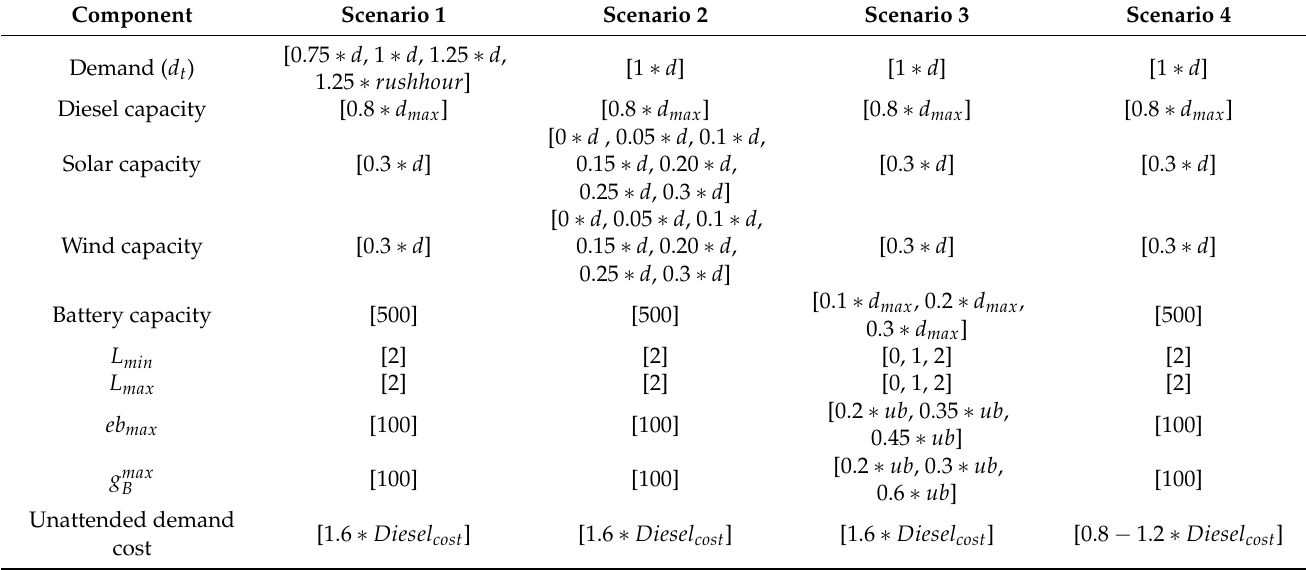
Table 1. Sets of experimental